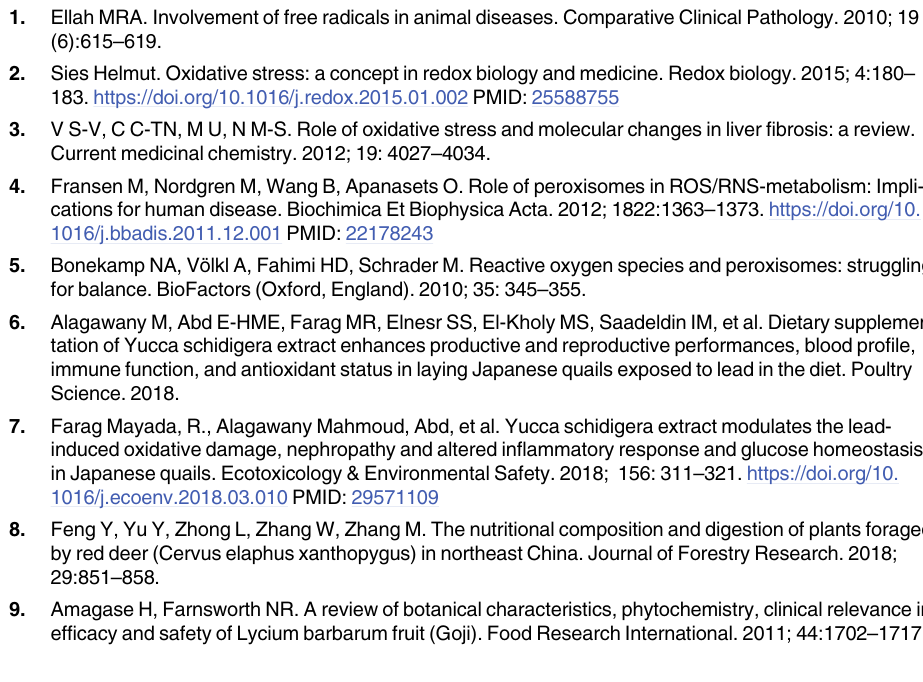
S3 Table. EST analysis of differential gene